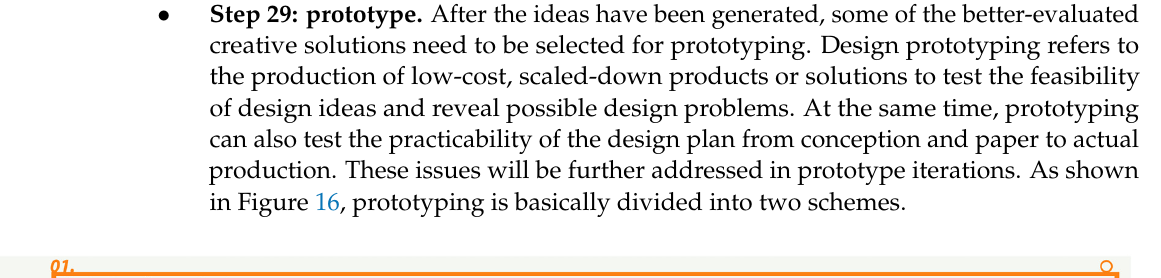
Figure 14. Examples of methods for demands research and definition.